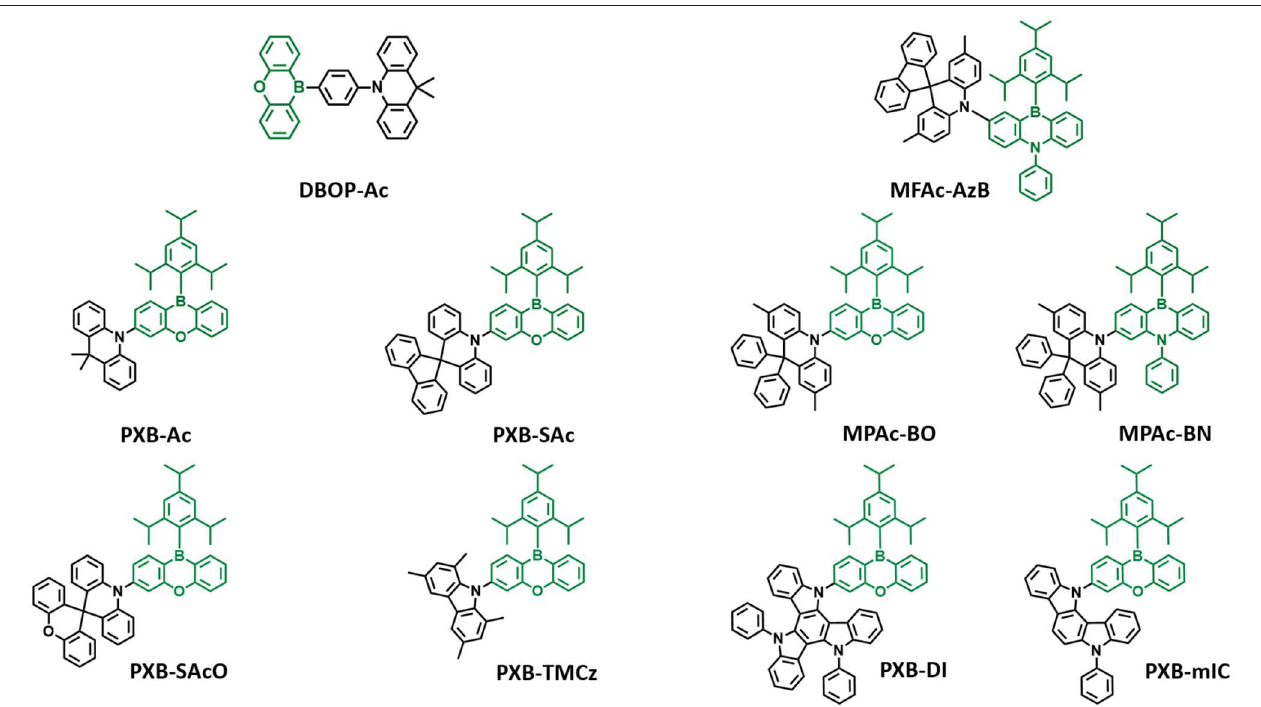
FIGURE 3 | Reported partially bridged boron acceptor for blue thermally activated delayed fluorescence (TADF) emitters. In these molecules, acceptor is highlighted in dark green color.